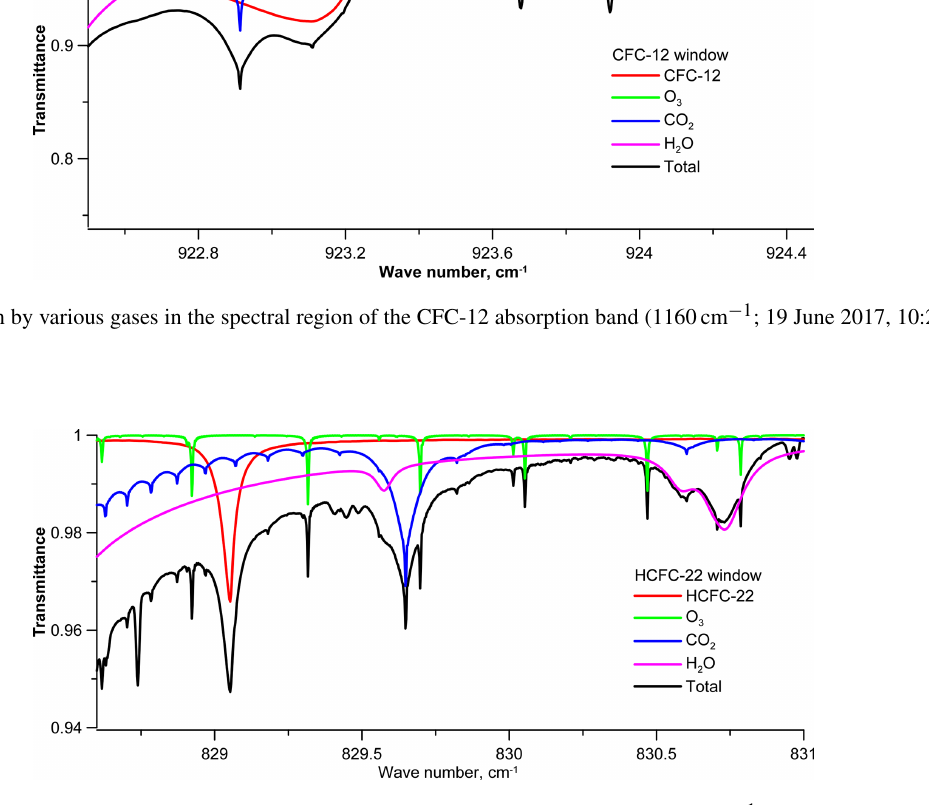
Figure A3. Absorption by various gases in the spectral region near the HCFC-22 absorption line (829cm − 1 ; 19 June 2017, 10:25UTC; SZA is 37 ◦